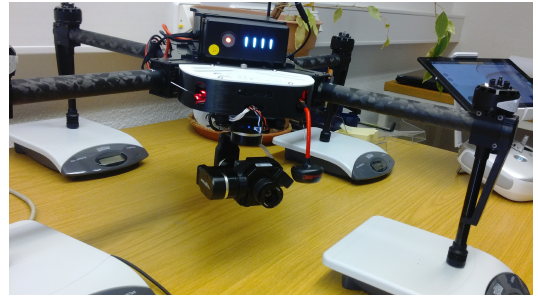
Figure 2. FLIR Tau2 640 LWIR attached on the drone DJI Matrice